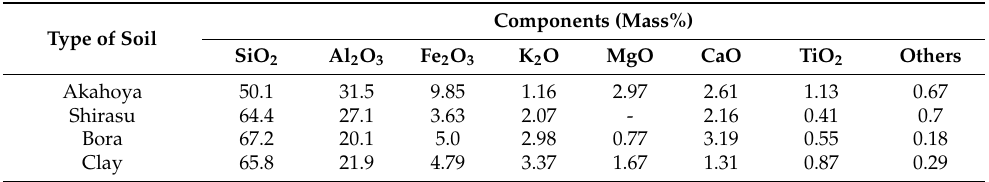
Table 1. Inorganic chemical compositions of the volcanic soils and clay.